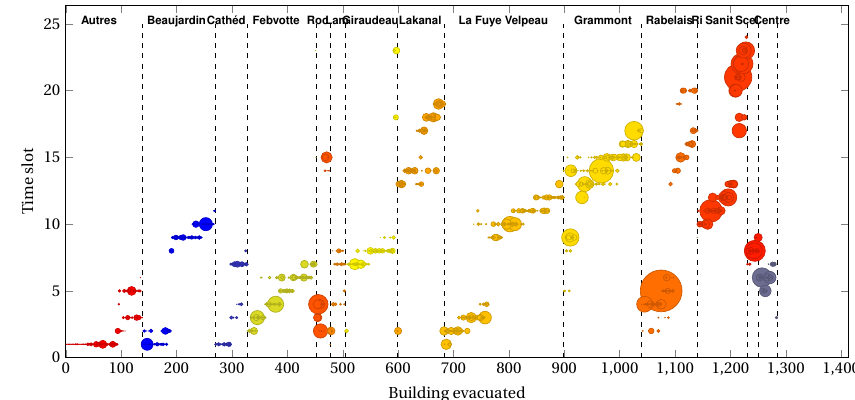
Figure 12. Priority list for the evacuation of buildings in the districts of Tours (exposures of districts according to destruction areas). Each building ( x axis) is represented by a circle where its size indicates the number of vehicles evacuated from this building. Each color represents a district.